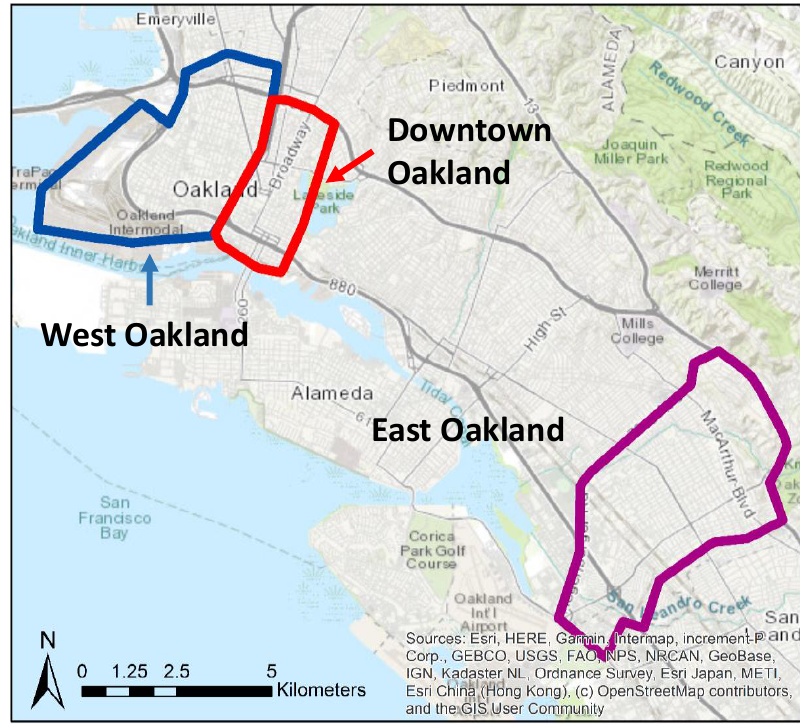
Figure 1. Study domain.